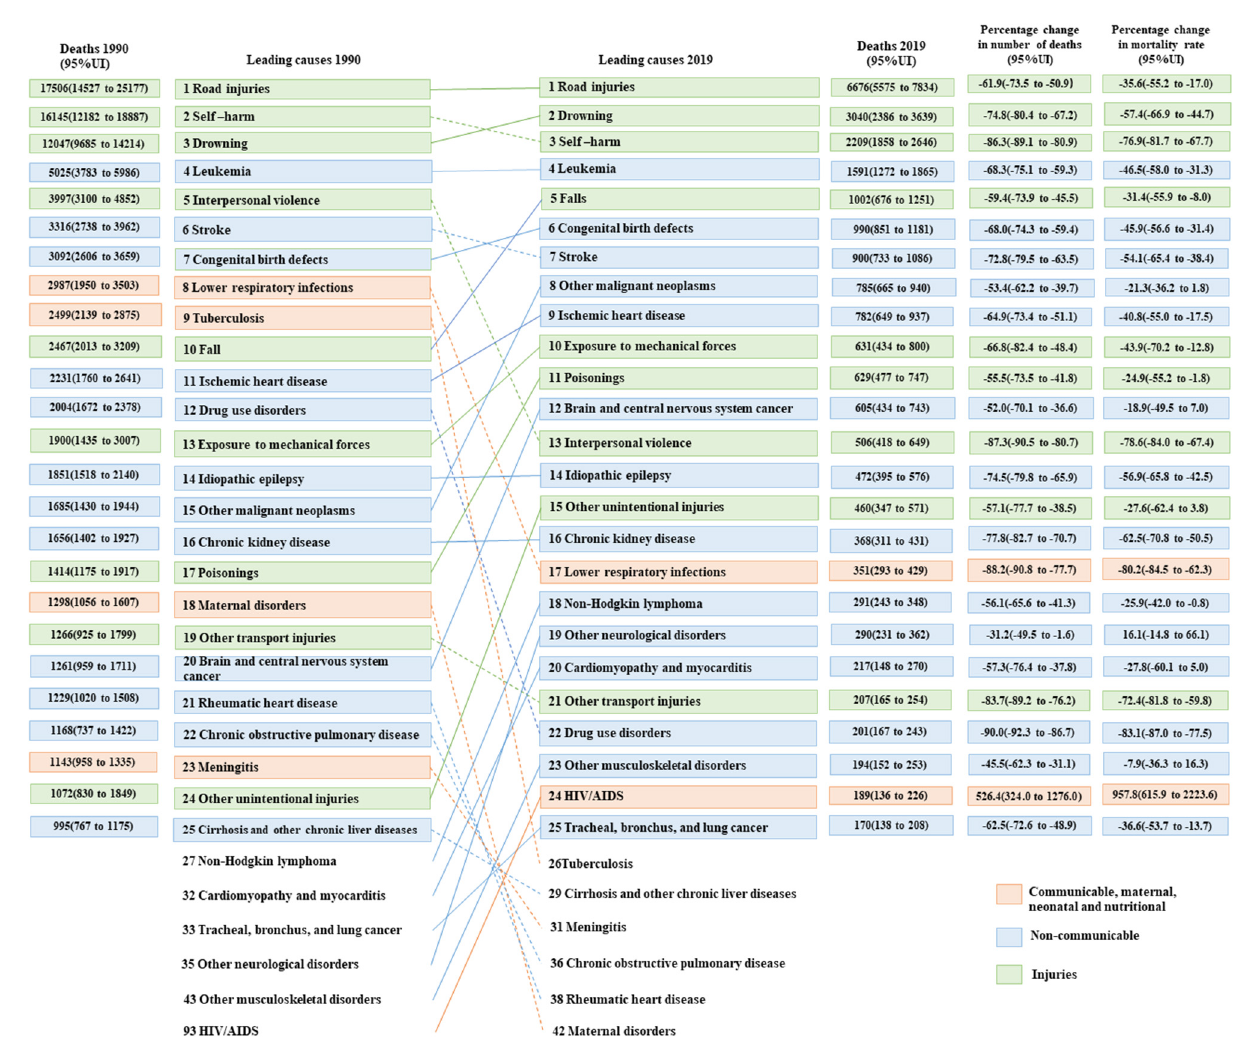
FIGURE5 Top 25 causes of death in China, aged 15–19 years, both sexes, 1990 and